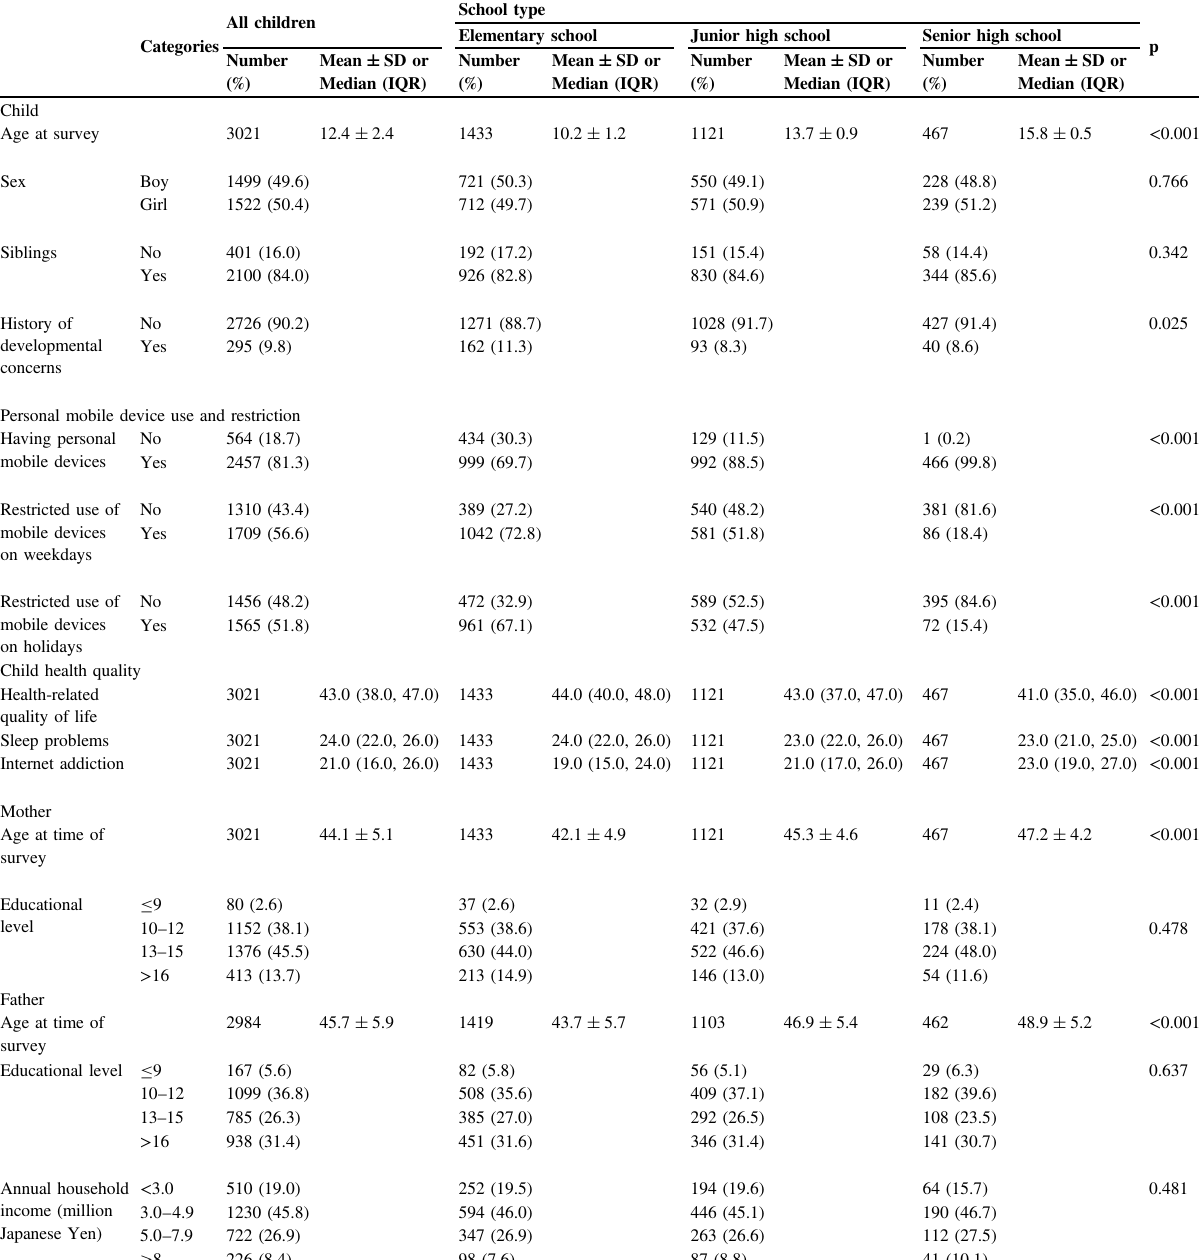
Table 1 Characteristics of participants (children and their